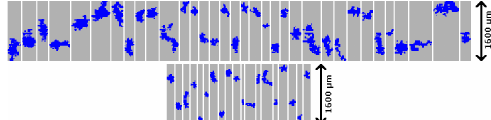
Figure 10. Images taken by the CIP during the mature (upper) and dissipating (lower panel) Hector phase. No developing Hector im- ages are shown since these were only a few pixels and no shapes can be inferred from them.